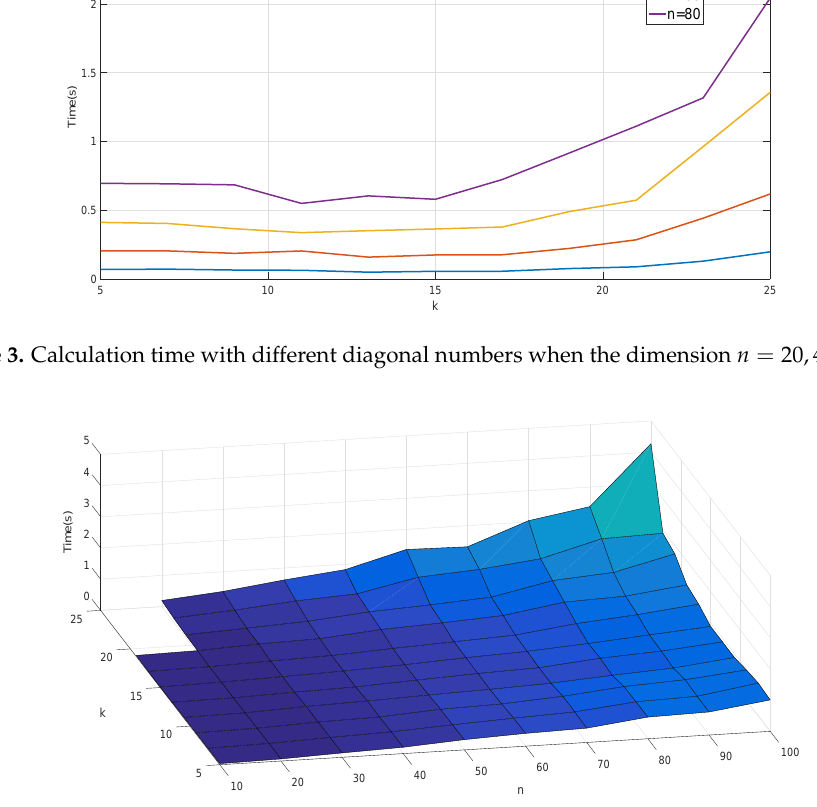
Figure 4. The variation of calculation time with different dimensions n and diagonal number k